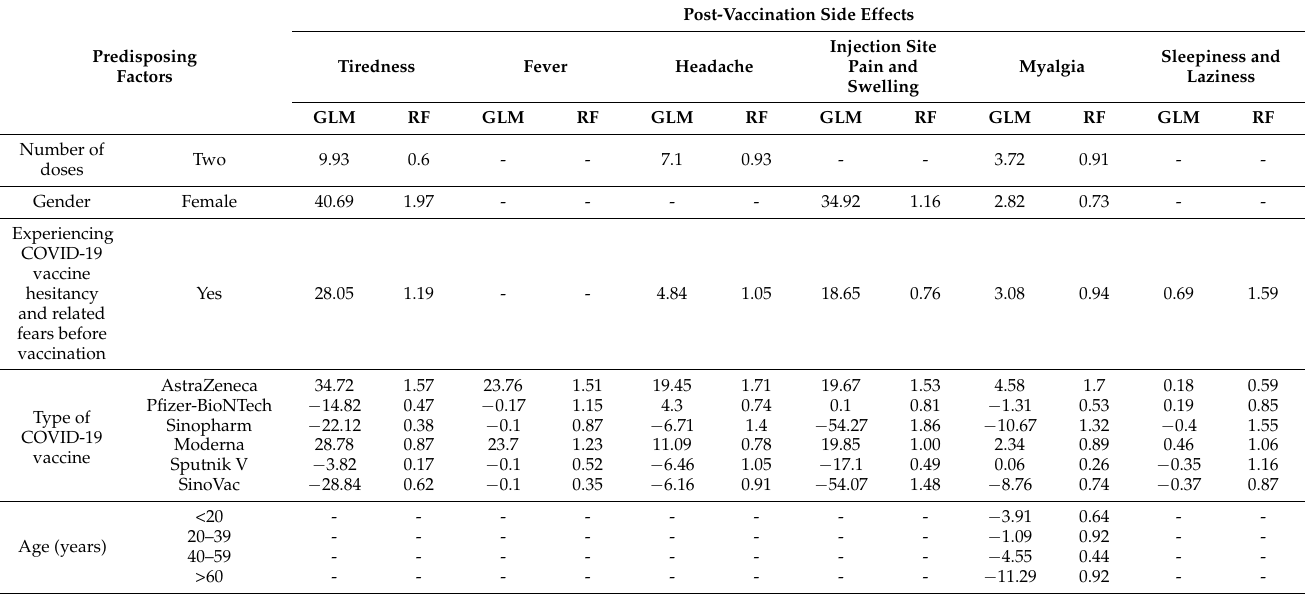
Table 8. Use of GLM/SRF to determine feature importance for different components of the critical features determined in Table